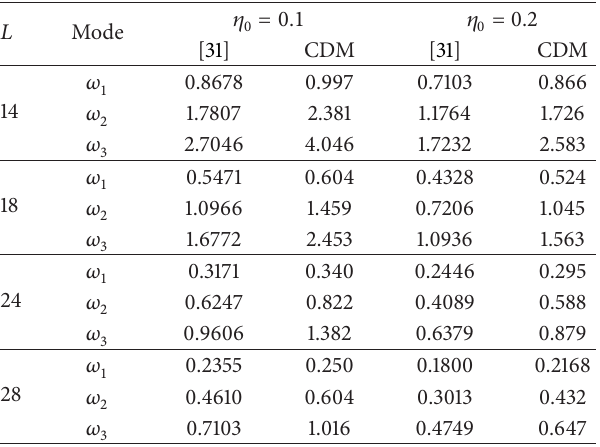
Table 11: Numerical comparison among [31] and CDM and the first three frequencies of vibrations of DWCNTs are reported (for 𝜂 0 = = 0.2 0.1 and 𝜂 0